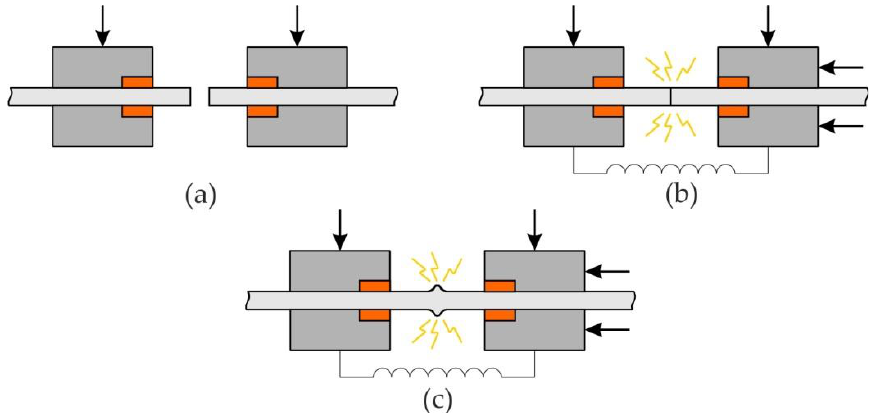
Figure 2. Flash butt welding of a bandsaw blade: ( a ) fixing the sheets in the device, ( b ) switching on the current flow with pressure, ( c ) ending the welding process.